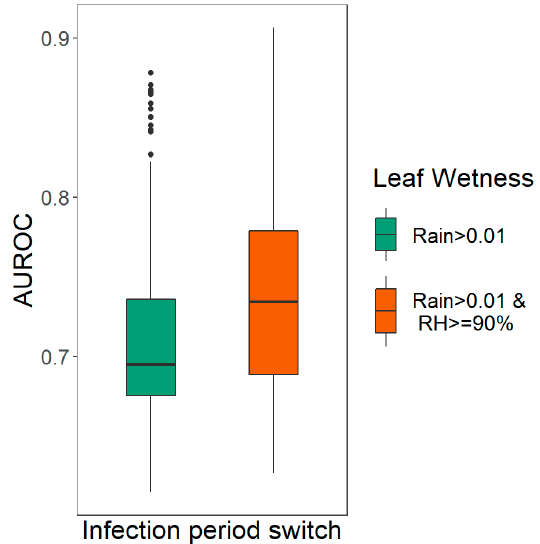
Figure 4. Group median difference between models with leaf wetness estimation using rain (> 0.1mm) or the combined rain and relative humidity (rain > 0.1 mm and RH ≥ 90%) as an estimator.